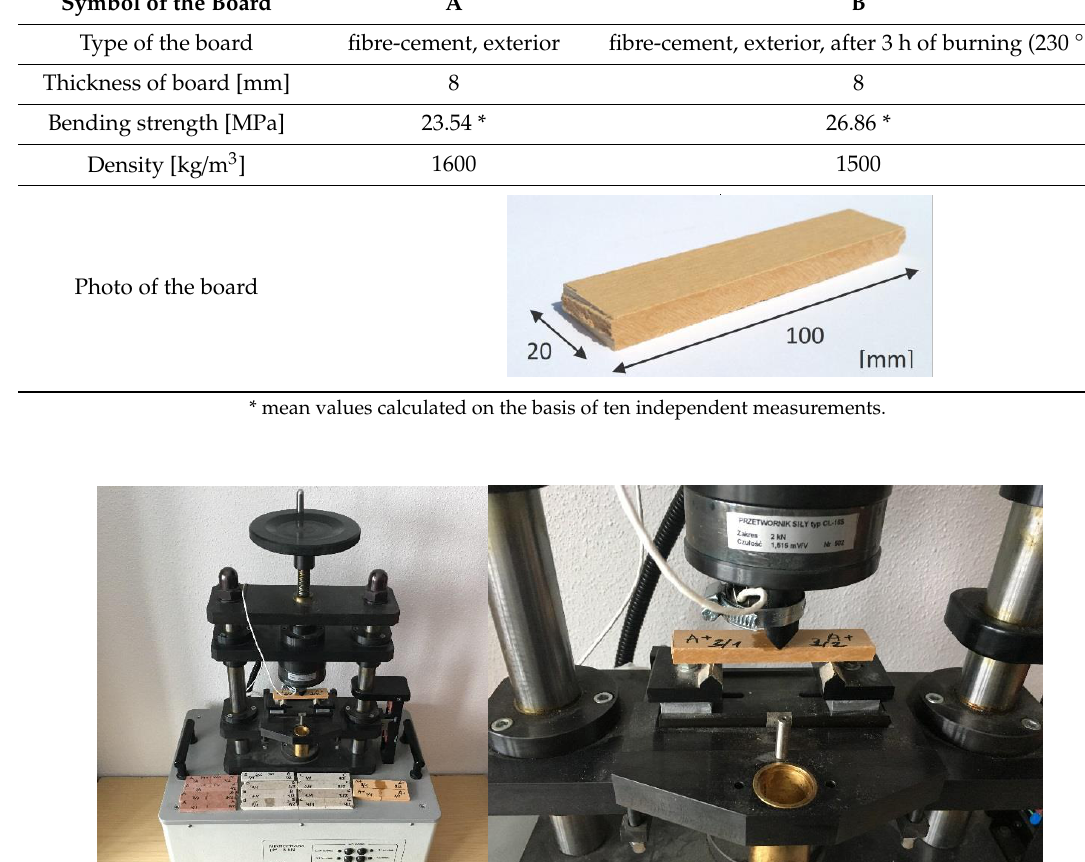
Table 1. Characteristic of the tested panels.